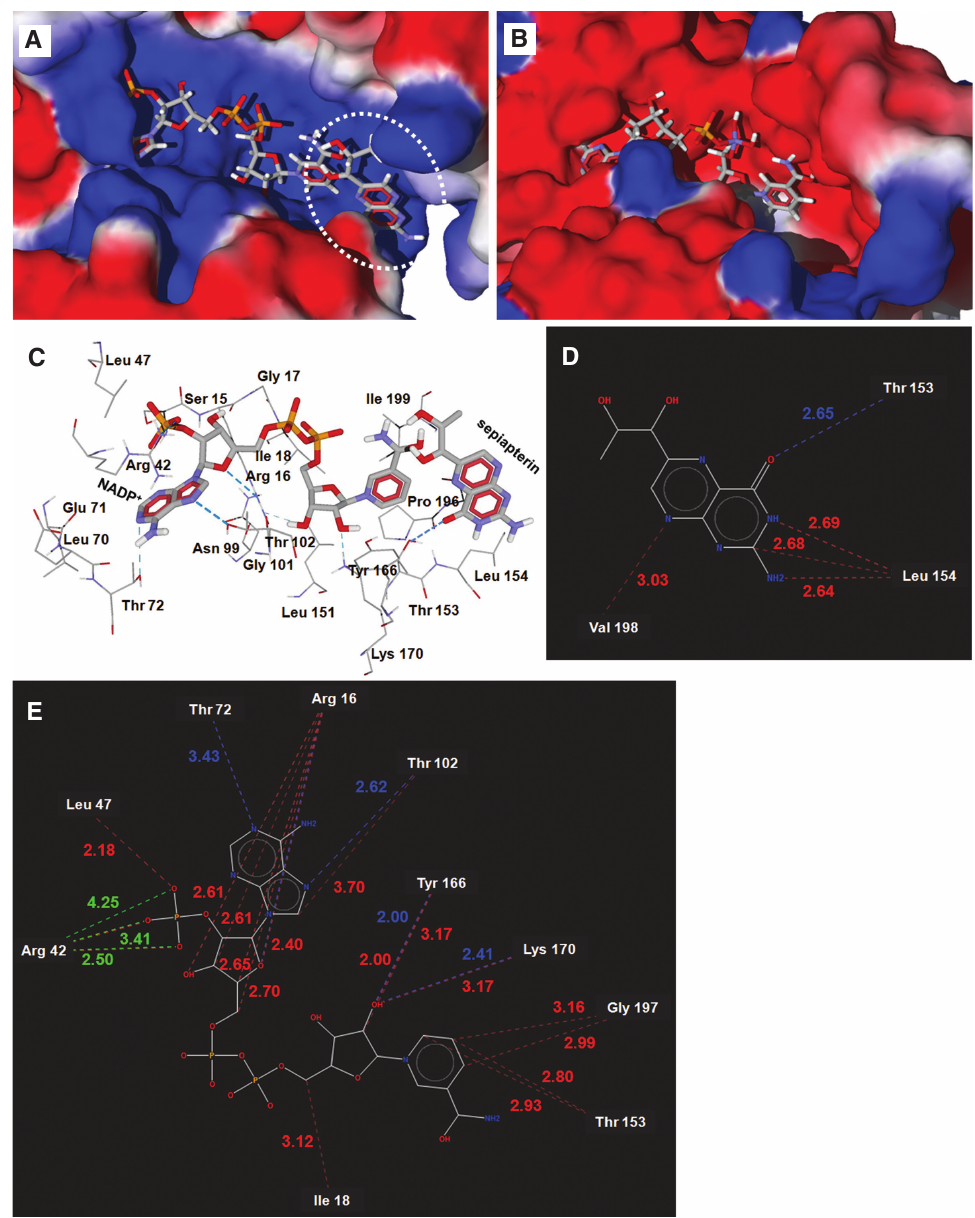
Figure 4: Structural comparison of substrate-binding sites in Drosophila SRs. (A and B) Potential surface electrostatic distributions of the substrate-binding site of two Drosophila SRs: CG12117 (A) and CG12116 (B). Positively charged surface distributions are colored in blue and the negatively charged distributions are colored in red. NADP + and biopterin are shown as stick models, with the carbon, oxygen, nitro- gen, and phosphate atoms indicated in gray, red, blue, and orange, respectively. The substrate-binding pocket is indicated by the white dotted circle. (C) Model displaying the binding of the substrate, NADP + , and biopterin at the substrate-binding site of CG12117. Blue dashed lines indicate the hydrogen bonds. (D and E) Schematic 2D diagram of the predicted interactions between biopterin and NADP + , and of the substrate-binding site of CG12117. Blue, green, and red dashed lines indicate the hydrogen bonds and the electrostatic and steric interac- tions, respectively. The corresponding bond distances (Å) are displayed according to the color coding of the interactions. The figures were generated using the Molegro Molecular Viewer